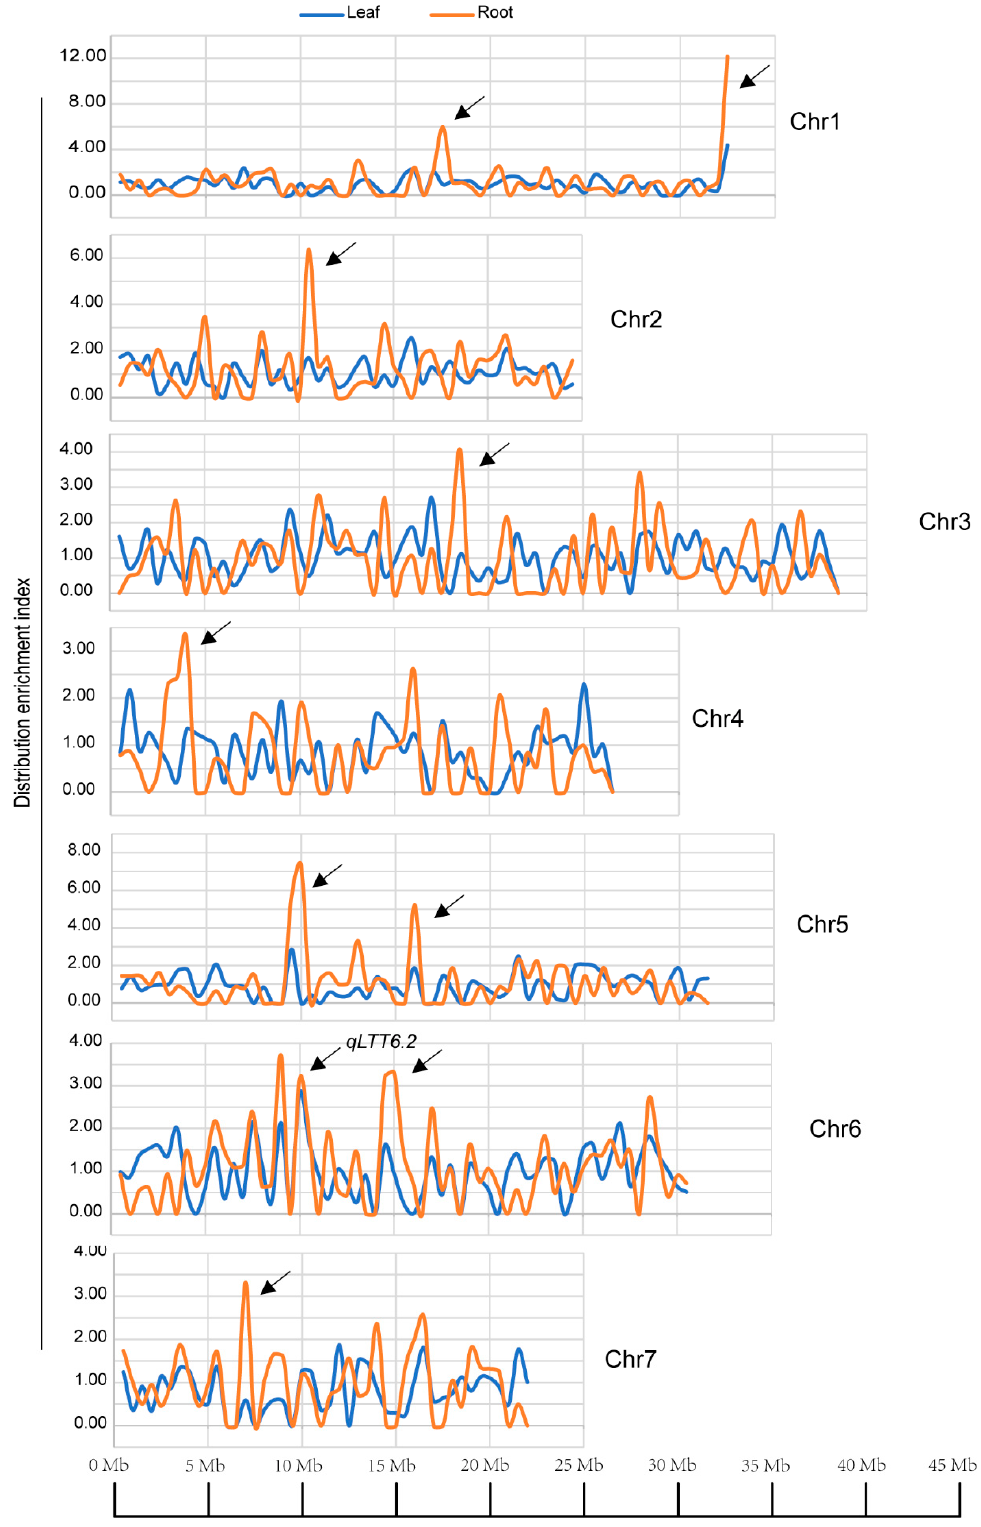
Figure 4. Distribution of DEGs on the seven chromosomes. Distribution enrichment index = (bin DEG number/total DEG number)/(bin gene number/total gene number); bin = 5 kb. The arrows indicate significant enrichments with an index of >3. Blue lines indicate enrichment of DEGs in the leaf (CT57S-leaf vs. CT90R-leaf); orange lines indicate enrichment of DEGs in the root (CT57S-root vs. CT90R-root).